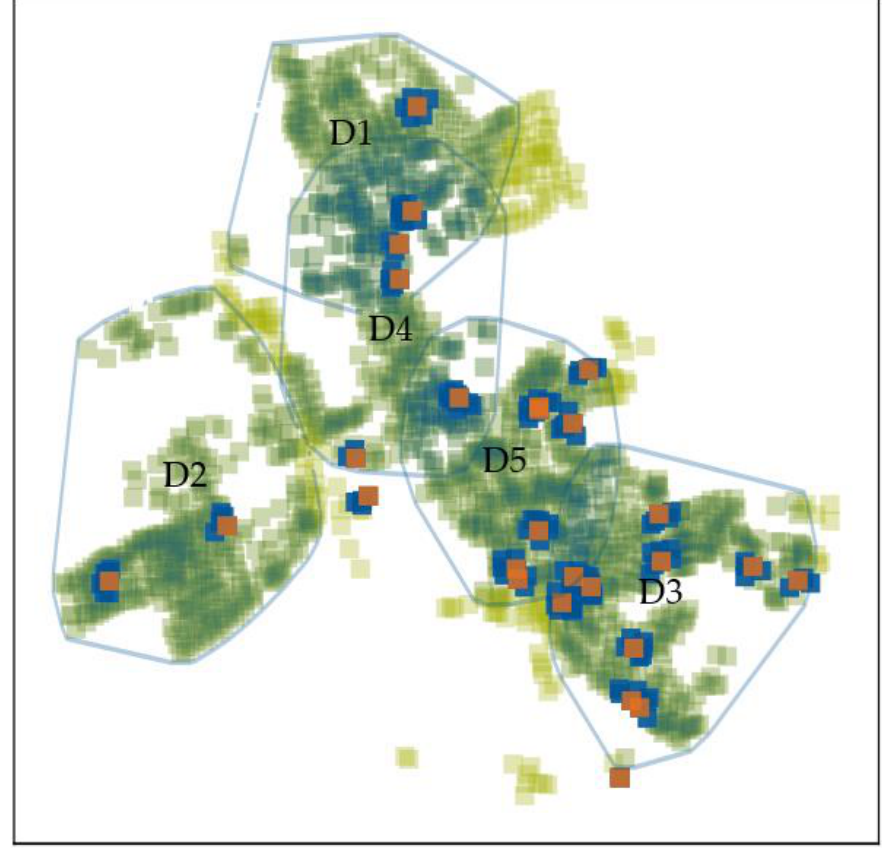
Figure 2. Visualization of training, validation, and test split for five cross-validation splits. The orange boxes illustrate the images used in the annotation experiment. They are surrounded by dark blue boxes that represent images excluded from the training and validation set to avoid overlap.